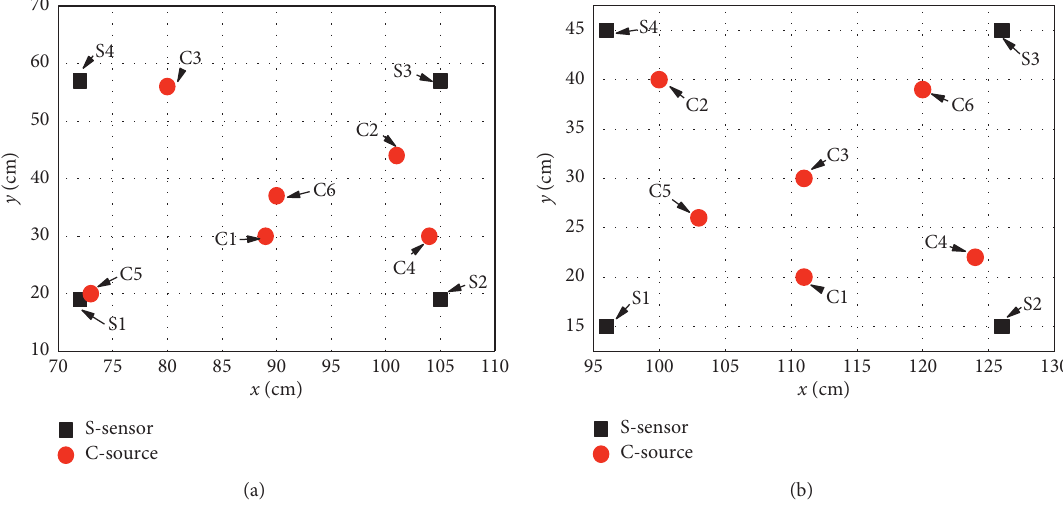
Figure 6: The coordinates of pulse sources and sensors in rectangular sensor arrays. (a) GAM-L. (b) G3761-L.